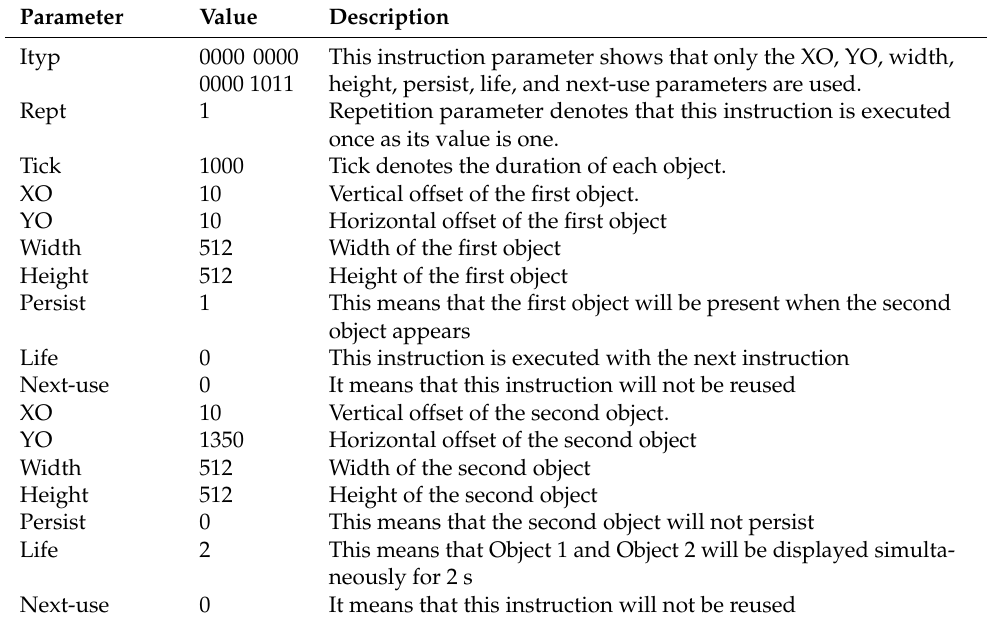
Table A9. Values of the INST parameters for the third example.